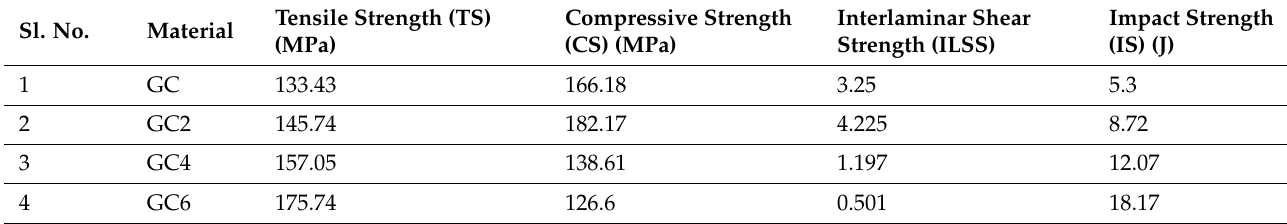
Table 4. Mechanical properties of filled